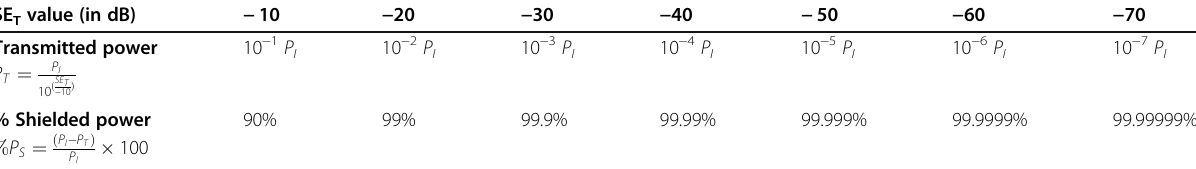
Table 1 Relation between SE T and the percentage of incident EM wave blocked by the shield material SE T value (in